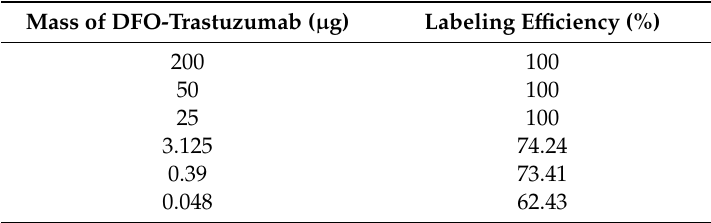
Table 2. ICP-MS analysis of three consecutive 89 Zr production runs. Table 1. The labelling e ffi ciency of 89 Zr with DFO conjugated trastuzumab were evaluated at 37 ◦ C with varying concentrations of conjugate in HEPES bu ff er, pH 7. A constant ~3.3 MBq of 89 Zr-oxalate was added to the DFO-trastuzumab solution for labeling.